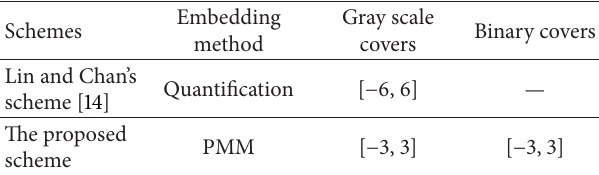
Table 4: The difference range for gray scale covers and binary scale